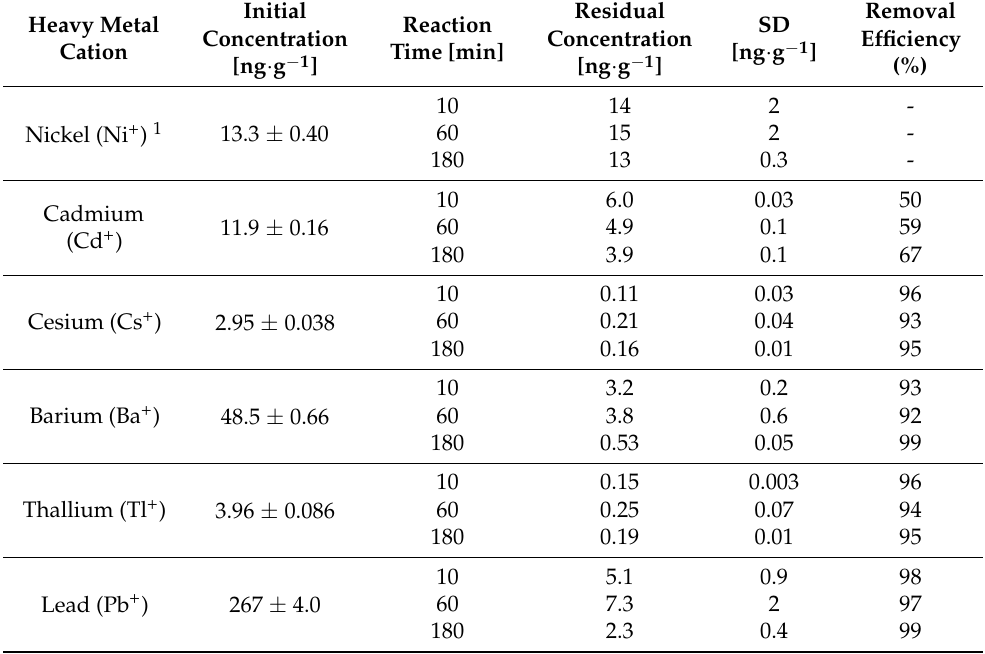
Table 9. Adsorption kinetics of studied heavy metal cations from heavy-metal-contaminated non- carbonated mineral water onto